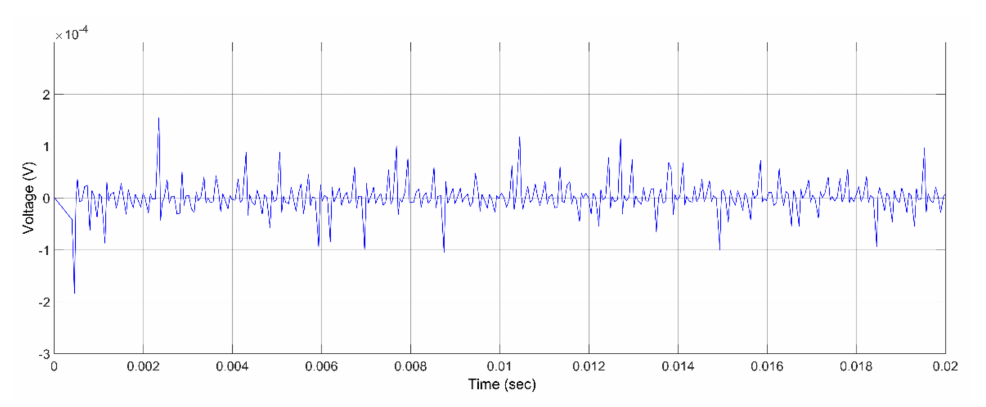
Figure 13. PD at 10 kV-Half Height.